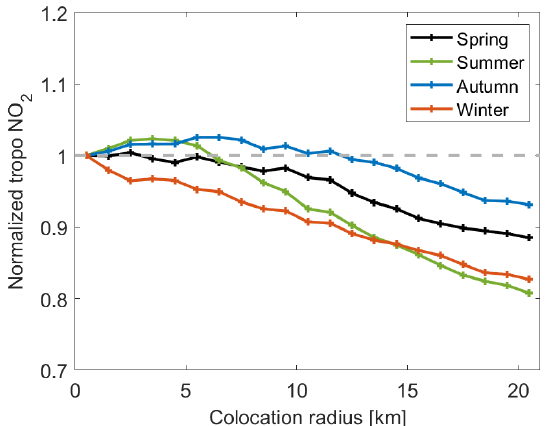
Figure 23. Normalized tropospheric NO 2 columns at increasing colocation radii for the Uccle station, estimated using seasonal mean TROPOMI data in